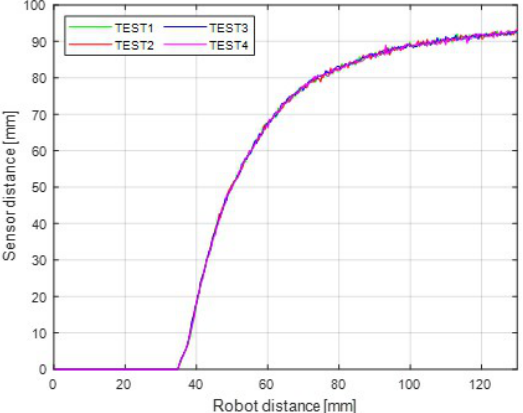
Figure 17. The proximity values recorded for the gut during the movement of the robot in four